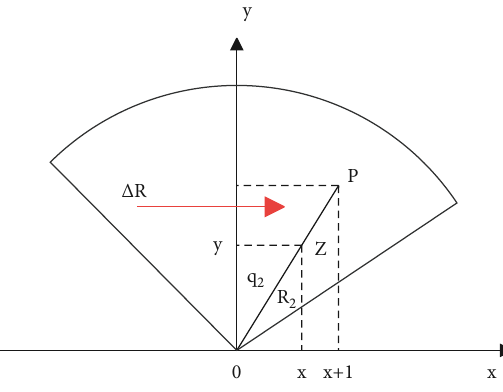
Figure 3: Incremental coordinate